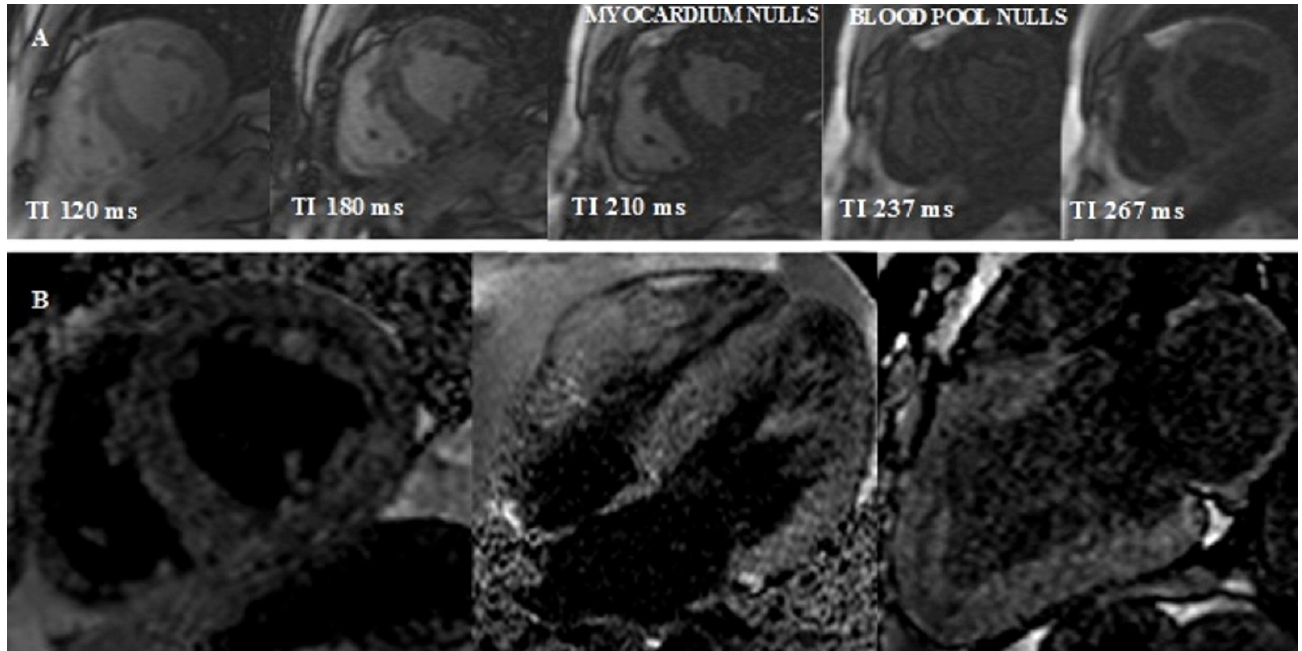
Figure 4. Reversed Look–Locker inversion time nulling pattern in cardiac amyloidosis. ( A ) Sequential Look–Locker inversion time (TI) mid-ventricular short-axis images are shown at increasing inversion times from left to right. Blood pool nulls after myocardium, which is an abnormal (reversed) nulling pattern. ( B ) Midventricular short-axis, 4-chamber, and 2-chamber LGE images demonstrate a dark blood pool and difficulty nulling the myocardium.